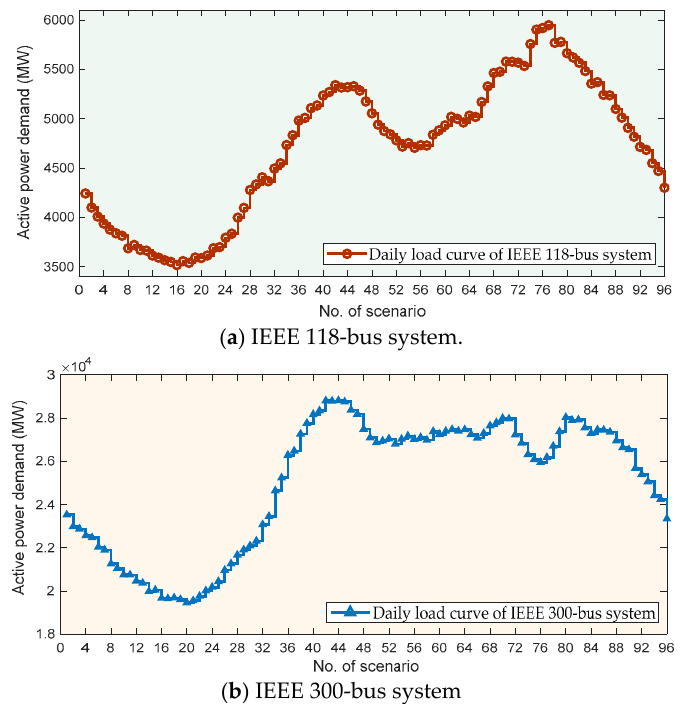
Figure 5. Typical daily load curves of the IEEE 118-bus system and IEEE 300-bus system.